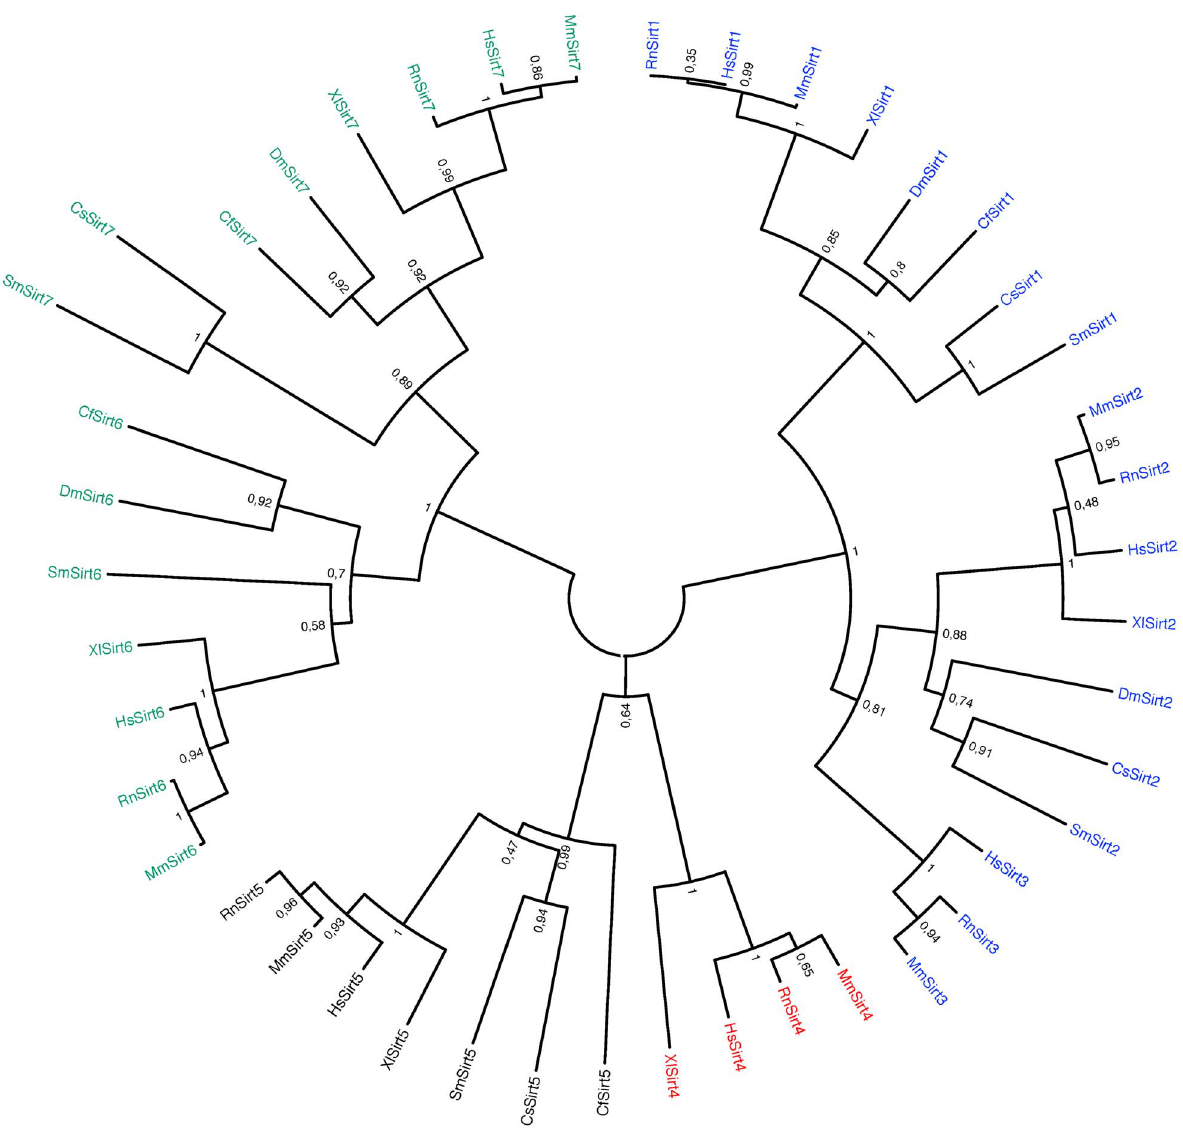
Figure 2. Phylogenetic analysis of S.mansoni sirtuins catalytic domains. The figure shows a phylogram generated by neighbour-joining analysis (see Methods) to emphasize the relationships between schistosome sirtuins and their orthologues. Class I sirtuins are shown in blue, Class II in red, Class III in black and Class IV in green. Sequences used were as in Figure 1 without C. elegans and A. californica sequences and with the addition of H. sapiens Sirt3 (HsSirt3: AAD40851.1) Sirt4 (HsSirt4: NP_036372.1), Mus musculus Sirt1 (MmSirt1: AAI52315.1) Sirt2 (MmSirt2: NP_071877.3) Sirt3 (MmSirt3: AAH25878.1) Sirt4 (MmSirt4: NP_598521.1) Sirt5 (MmSirt5: NP_849179.1) Sirt6 (MmSirt6: NP_853617.1) Sirt7 (MmSirt7: NP_694696.2), Rattus norvegicus Sirt1 (RnSirt1 XP_003753523.1) Sirt2 (RnSirt2 NP_001008369.1) Sirt3 (RnSirt3: NP_001099783.1) Sirt4 (RnSirt4: AAI67005.1) Sirt5 (RnSirt5 NP_001004256.1) Sirt6 (RnSirt6 NP_001026819.1) Sirt7 (NP_001100543.1), X. laevis Sirt1 (XlSirt1: NP_001091195.1) Sirt2 (XlSirt2: NP_001088636.1) Sirt4 (XlSirt4: NP_001084634.1) Sirt5 (XlSirt5: NP_001088966.1) Sirt7 (XlSirt7: NP_001088383.1), C. floridanus Sirt1 (CfSirt1: EFN72286.1). (Fig. 7A), Sirtinol (Fig. 7B) and MS3 (Fig. 7C) induced a reduction of about 30% in egg production and HR103 (Fig. 7D), MS13 (Fig. 7E) and CS13 (Fig. 7F) a reduction of around 20%.